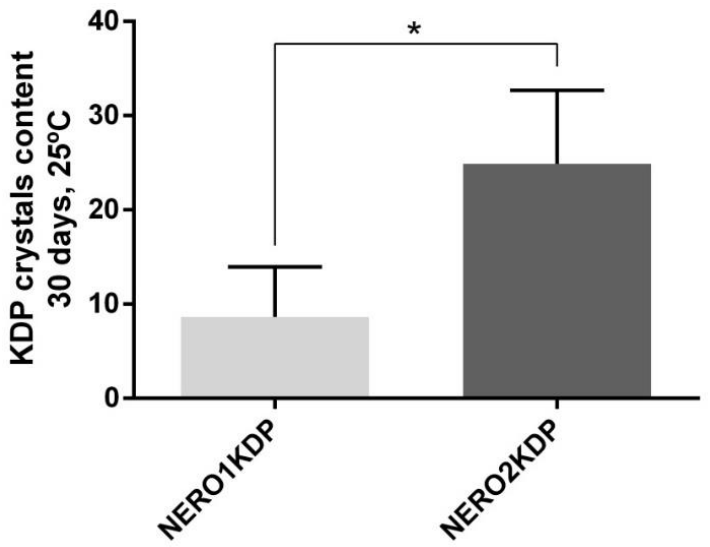
Figure 3. Crystal formation in 1 mg/mL (NERO1KDP) and 2 mg/mL (NERO2KDP) kojic dipalmitate (KDP)-loaded nanoemulsions after 30 days of storage at room temperature (25 °C). An asterisk in- (KDP)-loaded nanoemulsions after 30 days of storage at room temperature (25 ◦ C). An asterisk dicates a significant difference between groups ( p ≤ 0.05). indicates a significant difference between groups ( p ≤